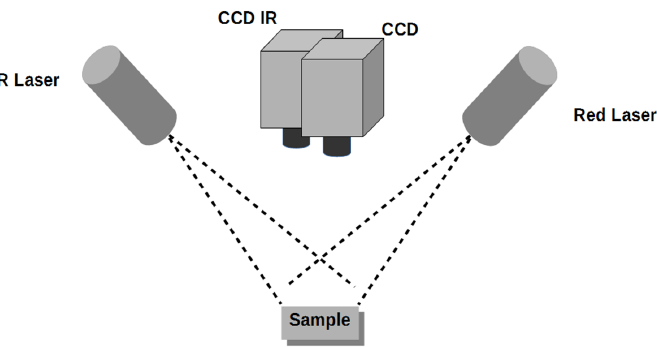
Figure 1. Common set-up of illumination and image acquiring with devices dedicated to red and IR (infrared) wavelength.